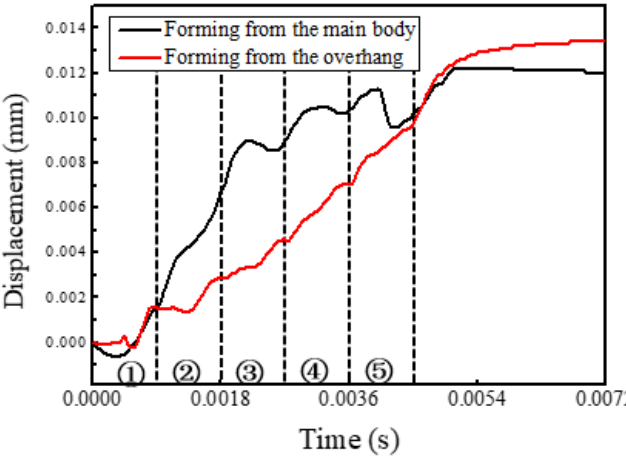
Figure 8. The displacement variations in the building direction with time at the midpoints of both track